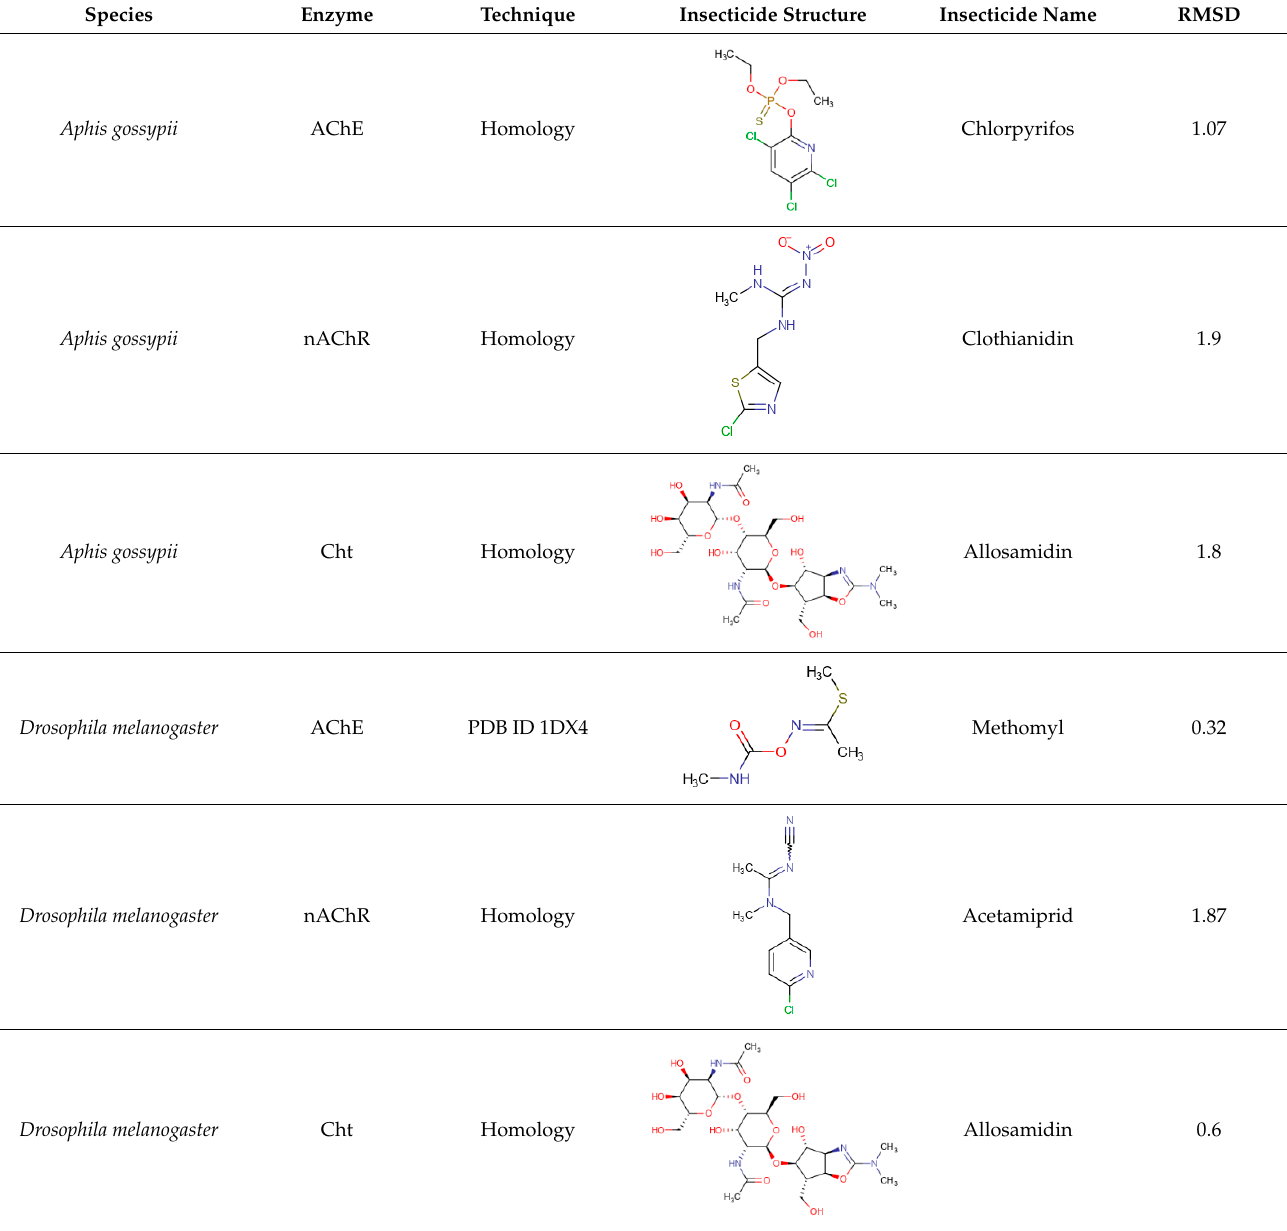
Table 12. Information on the AChE, nAChR, and Cht enzymes for each species selected in the study.